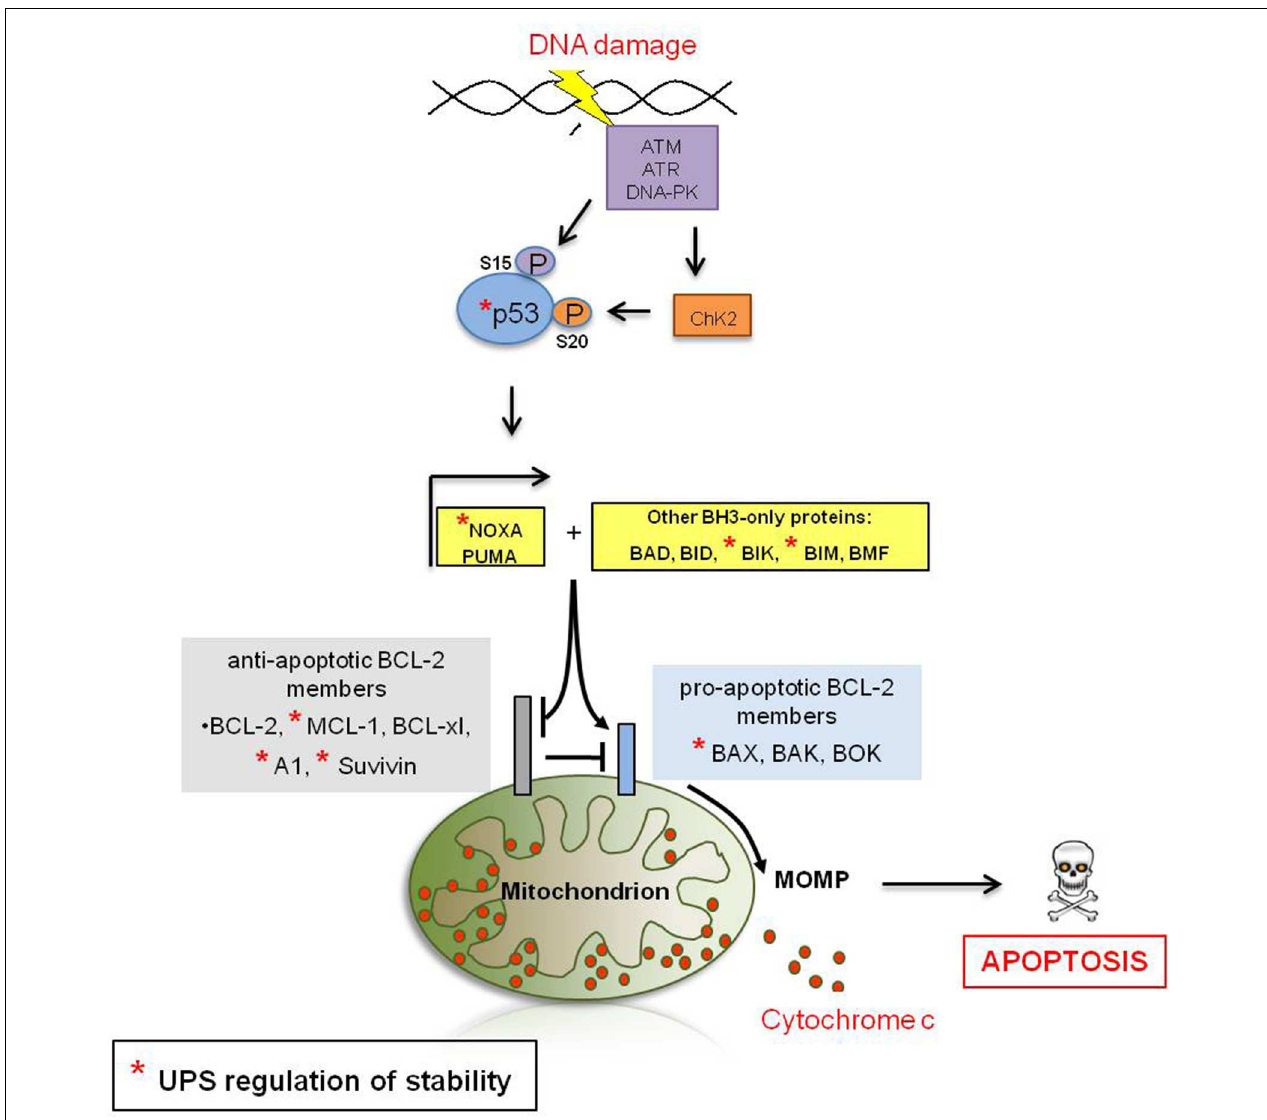
stabilization of p53. Activated p53 translocates into the nucleus where it induces the transcription of several targets involved in cell cycle regulation, DNA repair or apoptosis, including the pro-apoptotic molecule BAX (Miyashita and Reed, 1995) and the BH3-only proteins PUMA